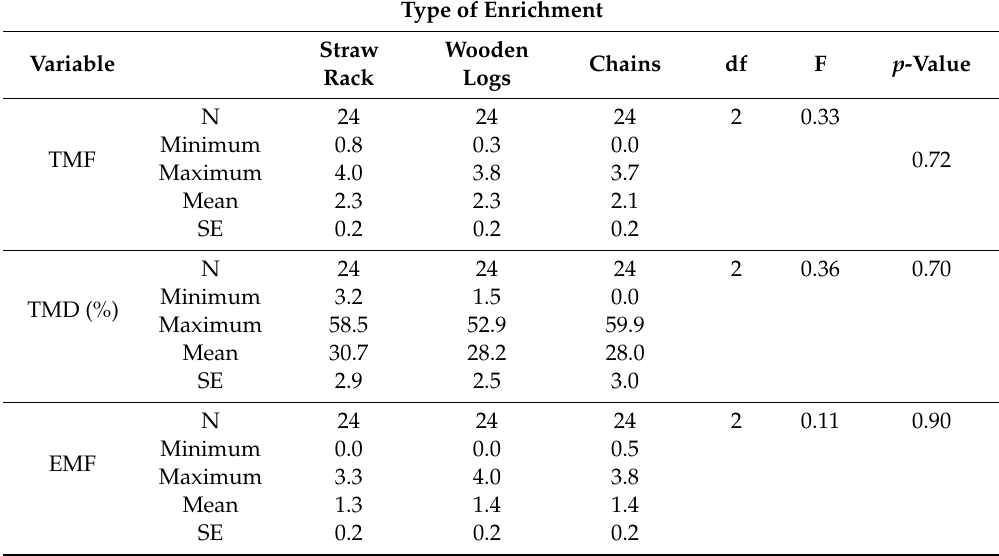
Table 1. Comparison of the variables (tail movement frequency, tail movement duration and ear movement frequency) over all 12 weeks in relation to the type of enrichment